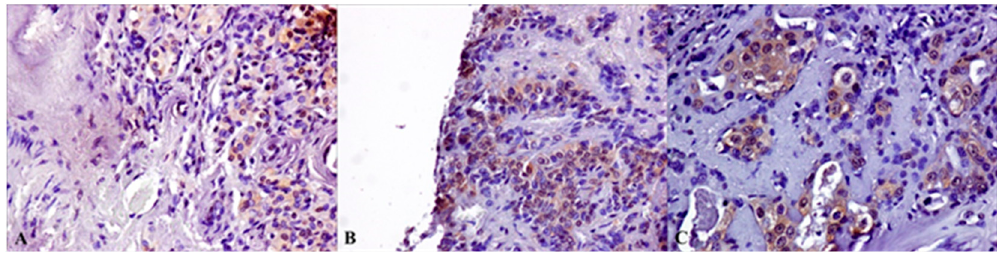
Figure 4. Cytoplasmic ER β IHC staining of SGTs samples: ( A ) ACC; ( B ) Myoepithelioma; ( C ) MEC (Magnification 20×).